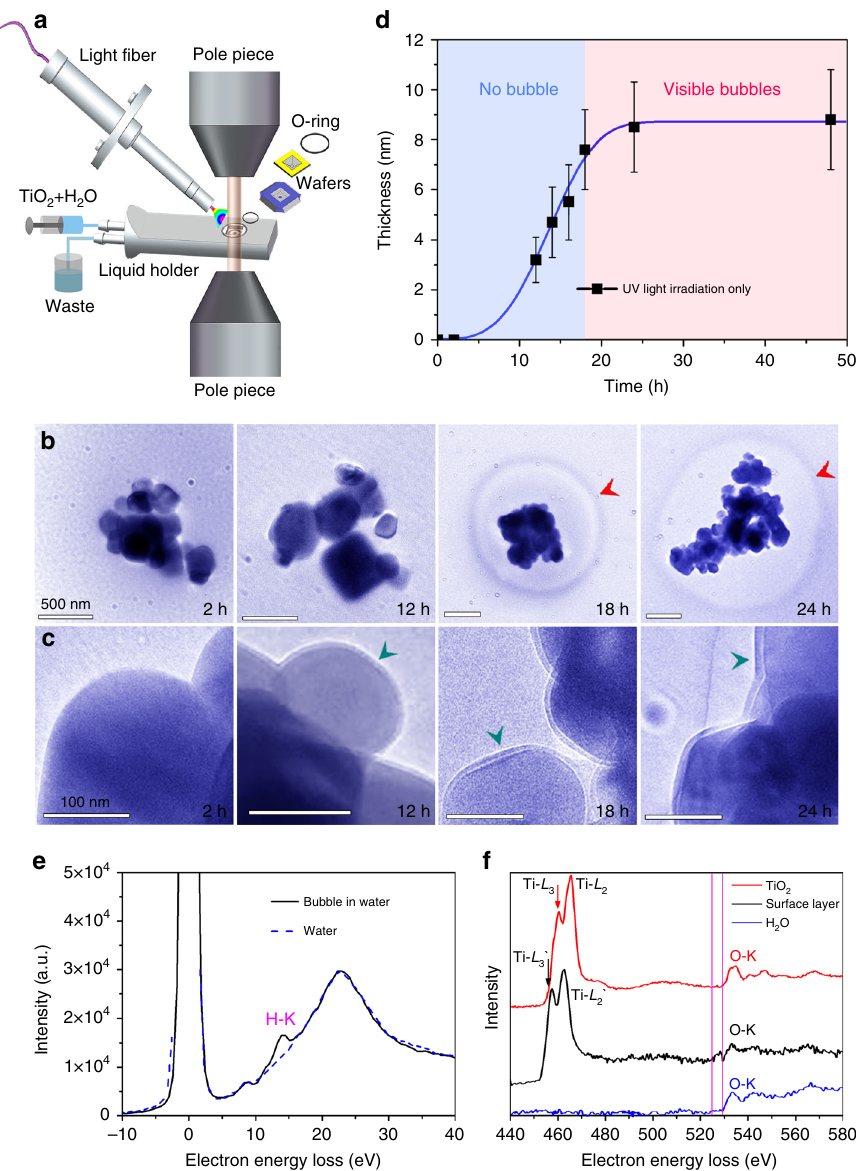
Fig. 1 TEM/EELS analyses of surface shell growth on anatase TiO 2 and hydrogen nanobubble formation after UV light illumination. a Experimental setup of a fl uidic TEM holder with function of in situ UV illumination (see details in Methods). Water-immersed TiO 2 NPs are injected into the liquid chamber of the fl uidic holder for TEM imaging. The UV illumination area covers the whole liquid chamber, which is about 3 mm. b Photocatalysis experiments with different times of UV exposure. Each TEM image is recorded independently with fresh aqueous suspensions of TiO 2 NPs controlled by the fl uidic holder. Red arrow indicates the gas bubble around the TiO 2 NPs. c Magni fi ed views of the TEM images in b . After 12 h of UV illumination, a surface shell of 3.2 nm (indicated by a green arrow) covering the anatase TiO 2 NPs is observed. d Thickness of the surface shell on anatase TiO 2 vs. UV illumination time: experimental data (black squares) and fi tted curve based on the KJMA equation 21 (blue line). Growth of the surface shell abruptly decreases when the bubbles are visible at ~18 h (reddish area). e EELS spectra from the bubble (black line) and from the pure water region (dashed blue line). f EELS for the initial crystalline surface of TiO 2 (red curve), the surrounding water (blue curve), and the surface shell (black curve). Purple vertical lines highlight the pre-edge feature at ~527 eV, before the O-K edge in the spectrum of surface